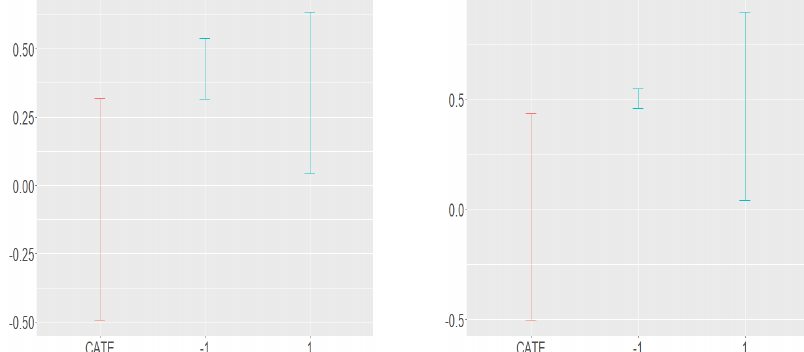
Figure 3. IV CATE and counterfactual mean bounds for two subjects with IQ scores 84.00 and 102.45, where A = 1 and − 1 refer to education beyond high school or not,